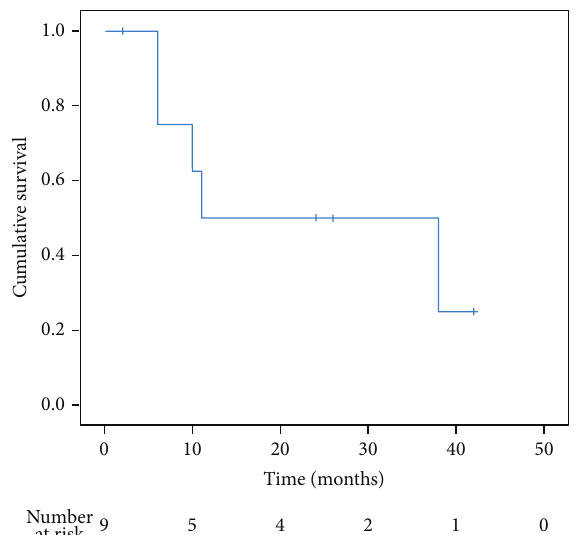
Figure 1: Overall survival curve according to the Kaplan-Meyer method.